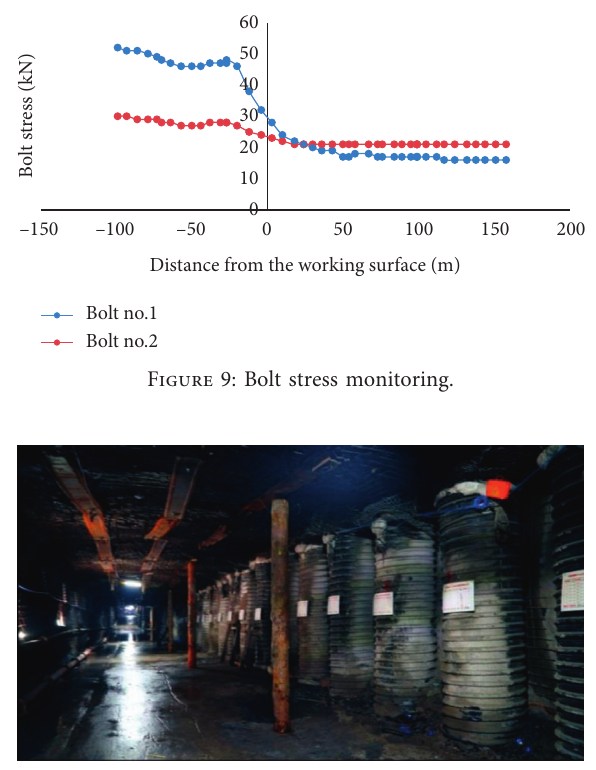
Figure 10: The effect of gob-side entry retaining 100m behind the working face.